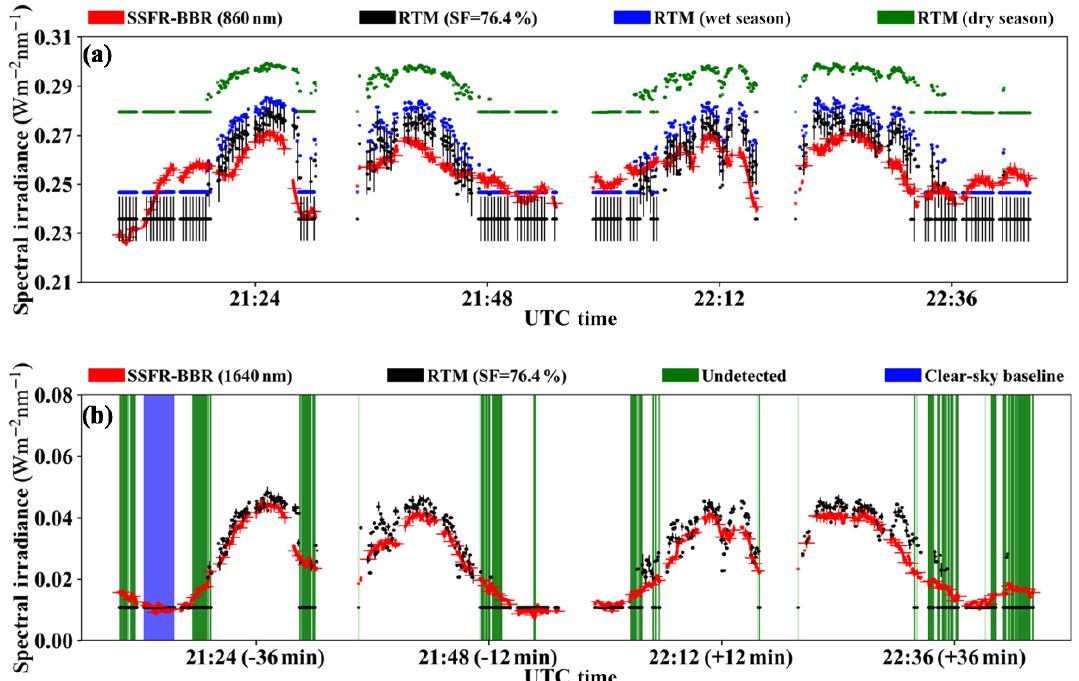
Figure 11. Spectral upwelling irradiance at 860nm (a) and 1640nm (b) from SSFR–BBR (red) and MODIS COPs RTM calculations using “13 September surface albedo” with SF = 76.4% (black) on 11 September. In addition, calculations with climatological snow albedos are shown in (a) (Arctic wet season: 0.75; Arctic dry season: 0.85). The time periods where clouds were not detected are marked in green in (b) . The clear-sky period that was used to determine the snow fraction is highlighted in blue in (b) . The uncertainties of the spectral irradiances are indicated as vertical error bars, and the horizontal error bars correspond to the radiometer FOV as in Fig. 7. Both need to be considered to identify undetected